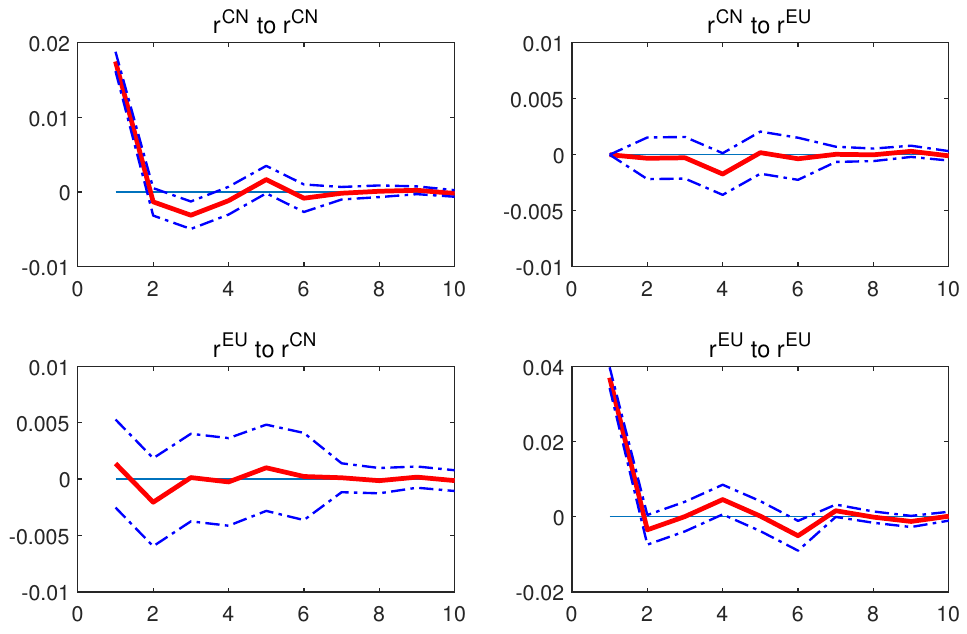
Figure 2. Impulse responses to a standard shock in a two-standard-error confidence